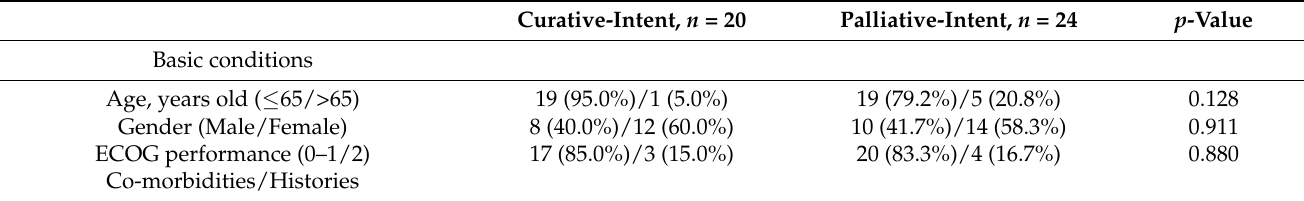
Table 1. Demographic and clinical characteristics of the metastatic gastric cancer patients who underwent